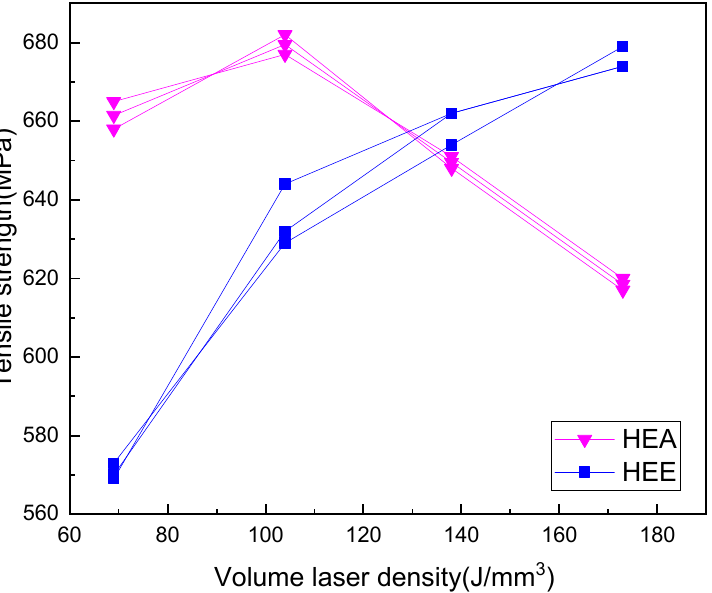
Figure 13. Tensile strength of as-printed samples with VE variation from 69 to 173 J/mm 3 . HEA: pre-alloyed powder samples. HEE: elemental powder samples.